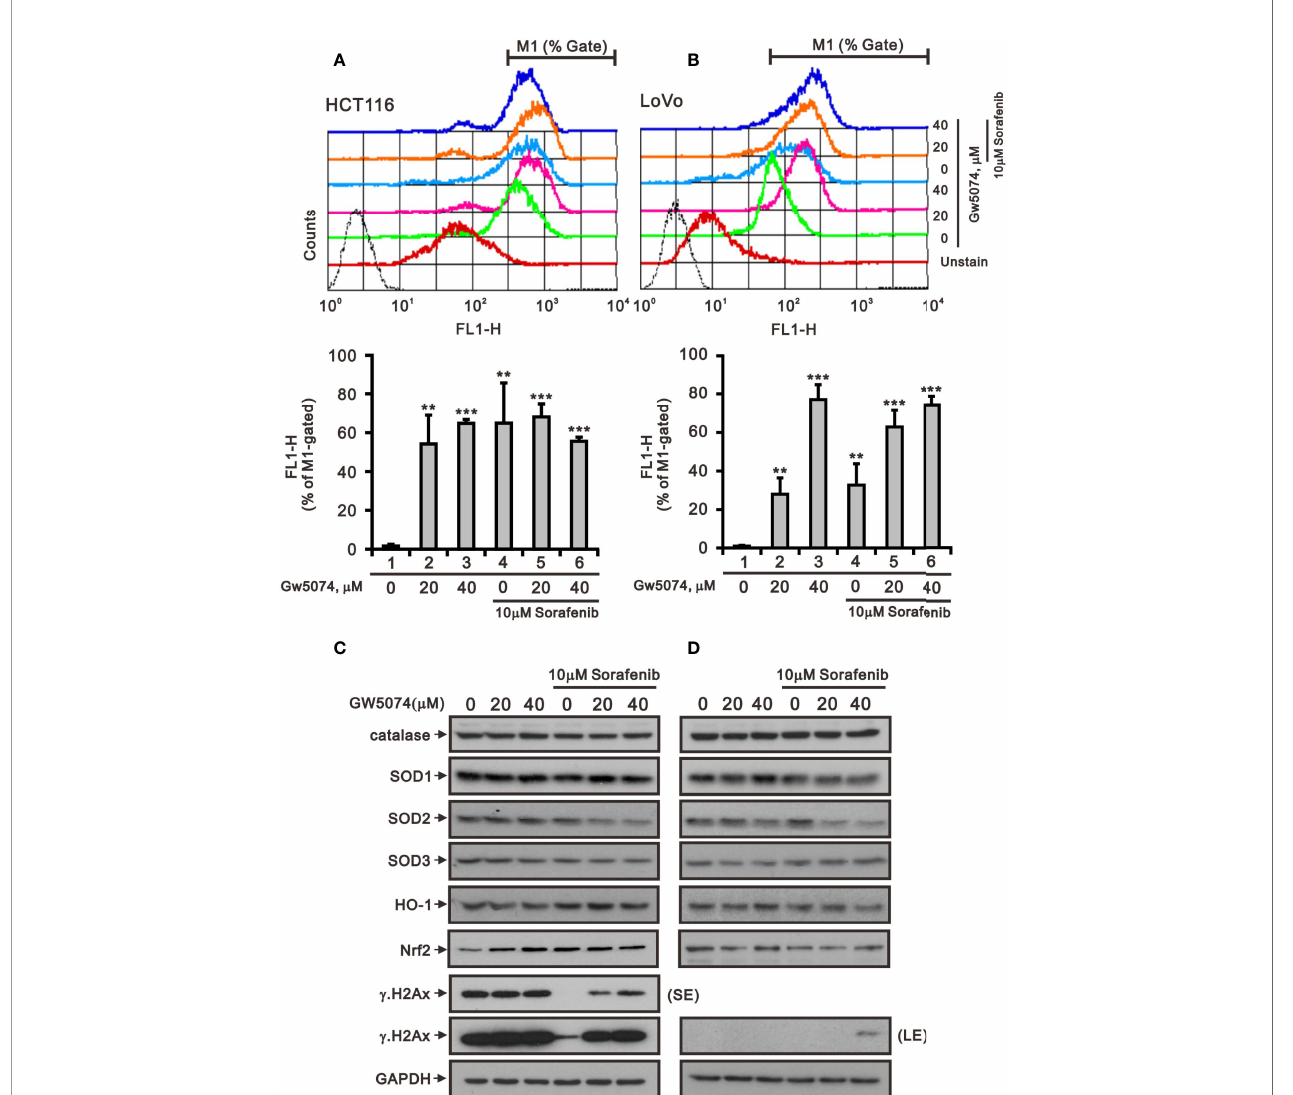
FIGURE 7 | The effects of GW5074 and sorafenib on the cytosolic ROS generation of HCT116 and LoVo cells. HCT116 (A) and LoVo (B) cells were treated with 0, 20, and 40 µM GW5074 in the absence or presence of 10 µM sorafenib for 24 h, after which the live cells were stained with 20 m M DCFH-DA for 10 min at 37°C and assayed using a fl ow cytometer. (C, D) Cell lysates were subjected to Western blotting analysis with antibodies against SOD 1-3, Nrf2, HO-1, and g H2A.x. GAPDH is a loading control protein. SE, shorter exposure; LE, longer exposure. The results (A, B) are representative of three independent experiments. **p < 0.01 and ***p <